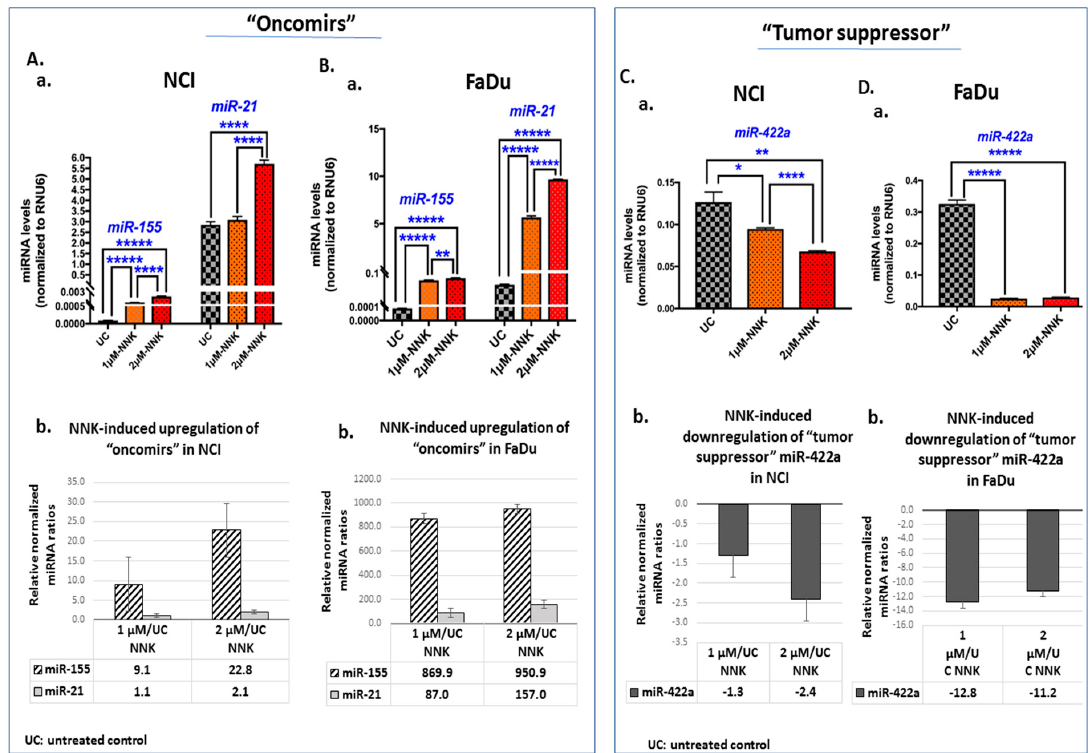
Figure 5. Either low or high dose of NNK induces deregulation of “oncomirs”, miR-21 and miR-155, and “tumor suppressor” miR-422a, in ( A ) NCI and ( B ) FaDu. ( A - a and B - a ) Graphs depict the expression levels of “oncomirs”, miR-155 and miR-21, in untreated and NNK-treated NCI and FaDu, respectively. ( A - b and B - b ) The graphs illustrate the NNK-induced upregulation of “oncomirs”, miR-21 and miR-155, in NCI and FaDu cells, respectively, as demonstrated by the relative expression ratios in NNK-treated (1 μ M or 2 μ M) versus untreated controls. ( C - a and D - a ) The graphs illustrate the NNK-induced downregulation of “tumor suppressor” miR-422a, in NCI and FaDu, respectively, as demonstrated by the relative expression ratios in NNK-treated (1 μ M or 2 μ M) versus untreated controls. [miRNA levels were normalized to RNU6 reference control. Data were obtained from three independent experiments; p values by t -test; * p < 0.05, ** p < 0.005, **** p < 0.00005, ***** p < 0.000005; GraphPad Prism 7.0, means (SD)].